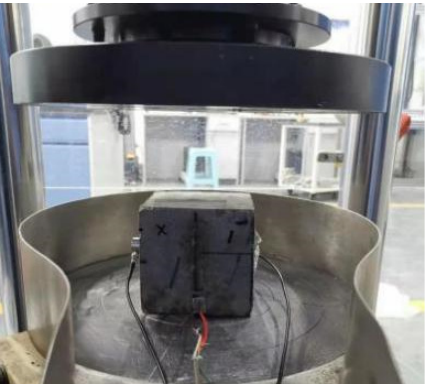
Figure 3. UCS test with AE.